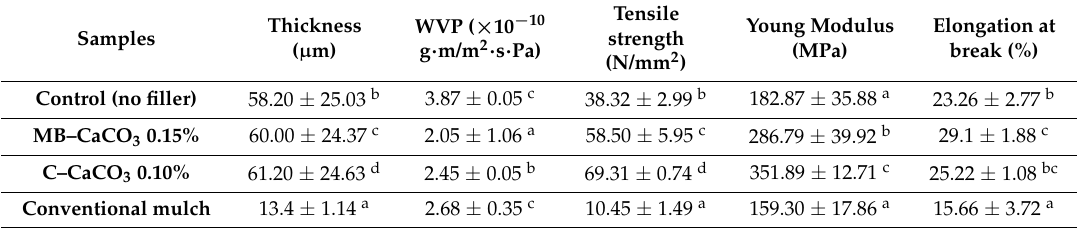
Table 1. Physical and mechanical properties of seaweed-based films and conventional mulch film.